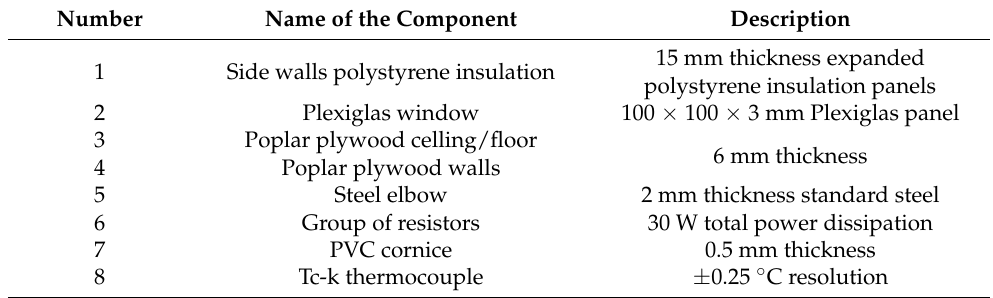
Table 1. Detailed specifications of the elements of the laboratory scale test platform (Figure 7).